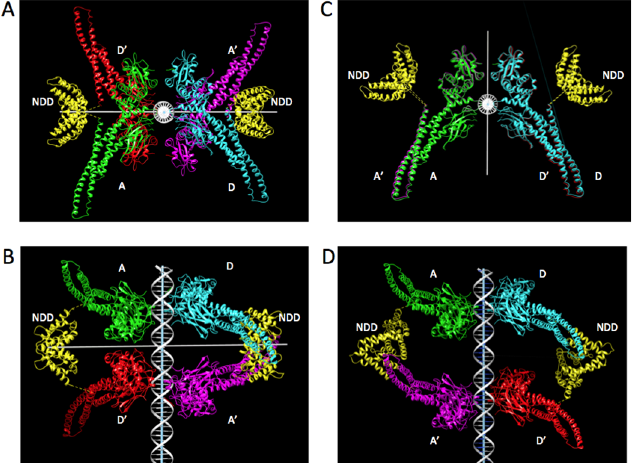
Fig 4. Two examples of the modeled tetramer structure. Left panels (NDD on-axis): The plan view ( A ) and elevation ( B ) of the tetramer model at the CTCD of 16; the horizontal white line is the 2-fold symmetry axis. Right panels (NDD off-axis): The plan view ( C ) and elevation ( D ) of the tetramer model at the CTCD of 21; the 2-fold axis is vertical in (C) and along the viewing direction in (D). In each panel, DNA is white; the core monomers are green (core A), blue (core D), magenta (A ’ ), and red (D ’ ); and NDDs are yellow. The linkers between the C-terminals of the NDD and the N-terminals of the core are indicated as dotted yellow